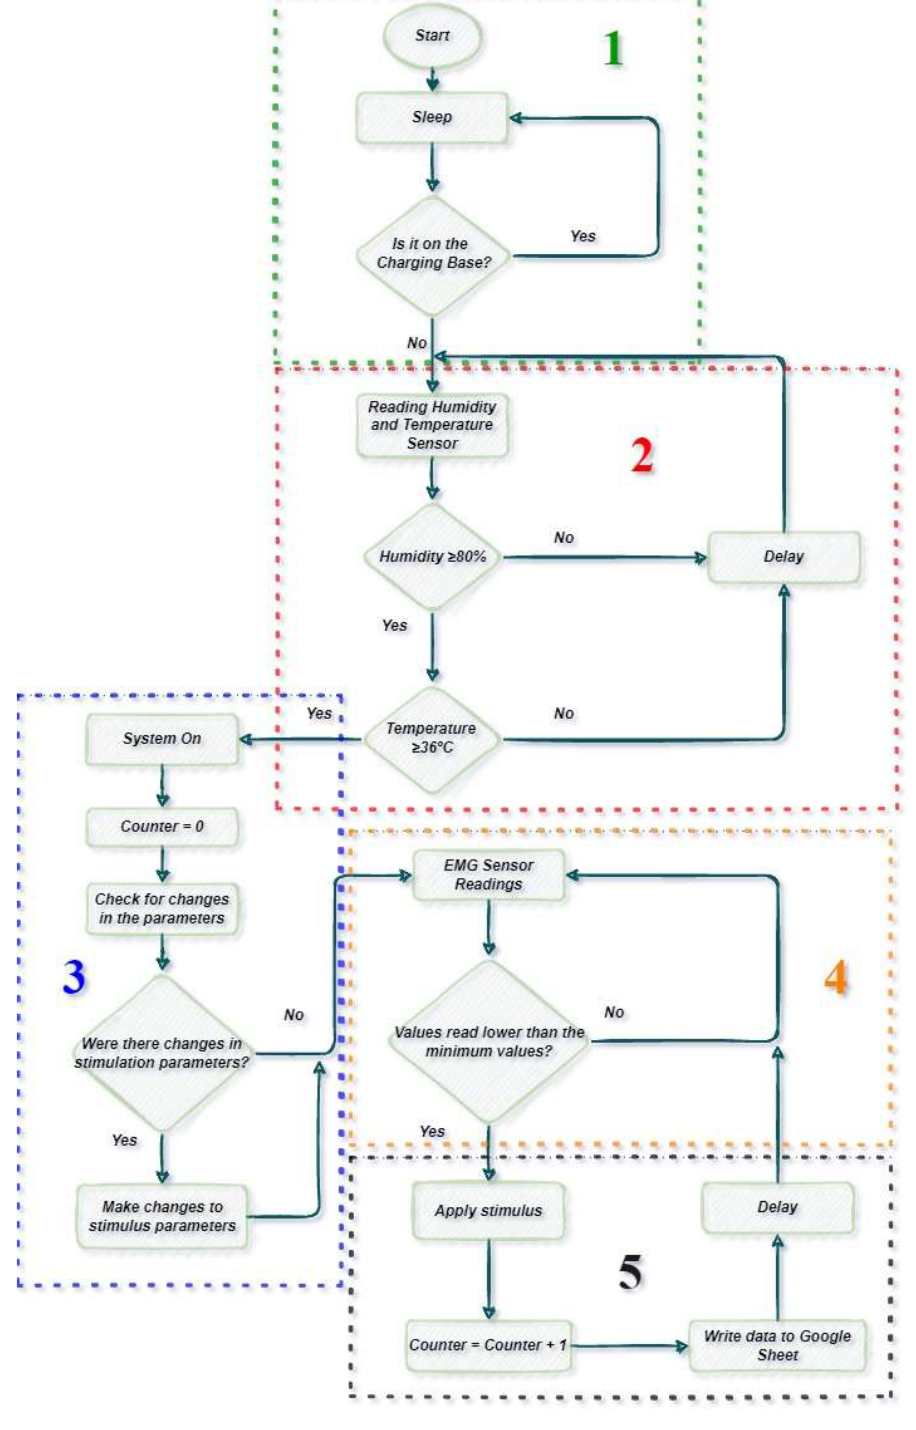
Figure 1. System flowchart.